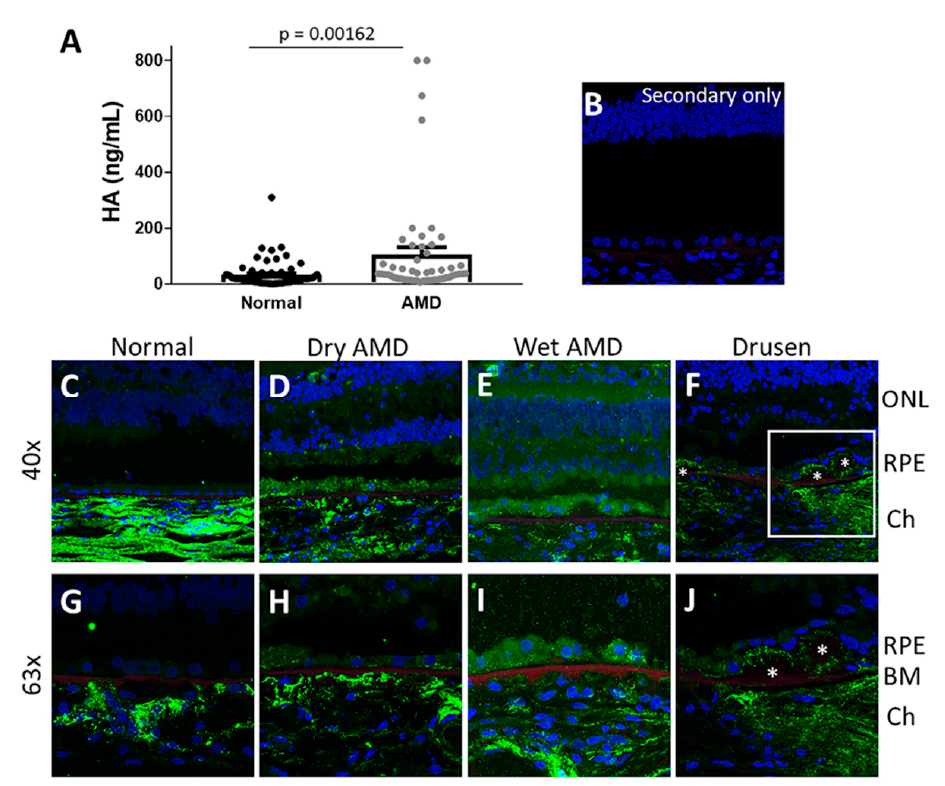
Figure 1. Hyaluronan HA is increased in circulation and in the RPE of age-related macular degeneration (AMD) patients. ( A ) HA was increased in plasma from patients with late-stage AMD (GA or CNV) compared to age-matched, normal controls. Data are presented as mean ± SEM ( B – J ) Representative human retina sections stained with HA binding protein (HABP) ( B ) Human retina section stained with streptavidin-AlexaFluor 647 in the absence of HA binding protein serves as a specificity control. ( C – J ) Human retina sections stained with streptavidin-AlexaFluor 647 in the presence of HA binding protein. HA is increased in the RPE in patients with dry AMD ( D , H ), wet AMD ( E , I ), and around drusen ( F , J ) compared to the RPE from an aged-match normal control ( C , G ). 40 × images ( B – F ), 63 × images ( G – J ). Green: HA; red: Bruch’s membrane determined by its autofluorescence at 405 nm; blue: DAPI. Asterisks indicate drusen ( F , J ). GA—geographic atrophy; CNV—choroidal neovascularization; ONL—outer nuclear layer; RPE—retinal pigment epithelium; Ch—choroid; DAPI—4 ′ ,6-diamidino-2-phenylindole.